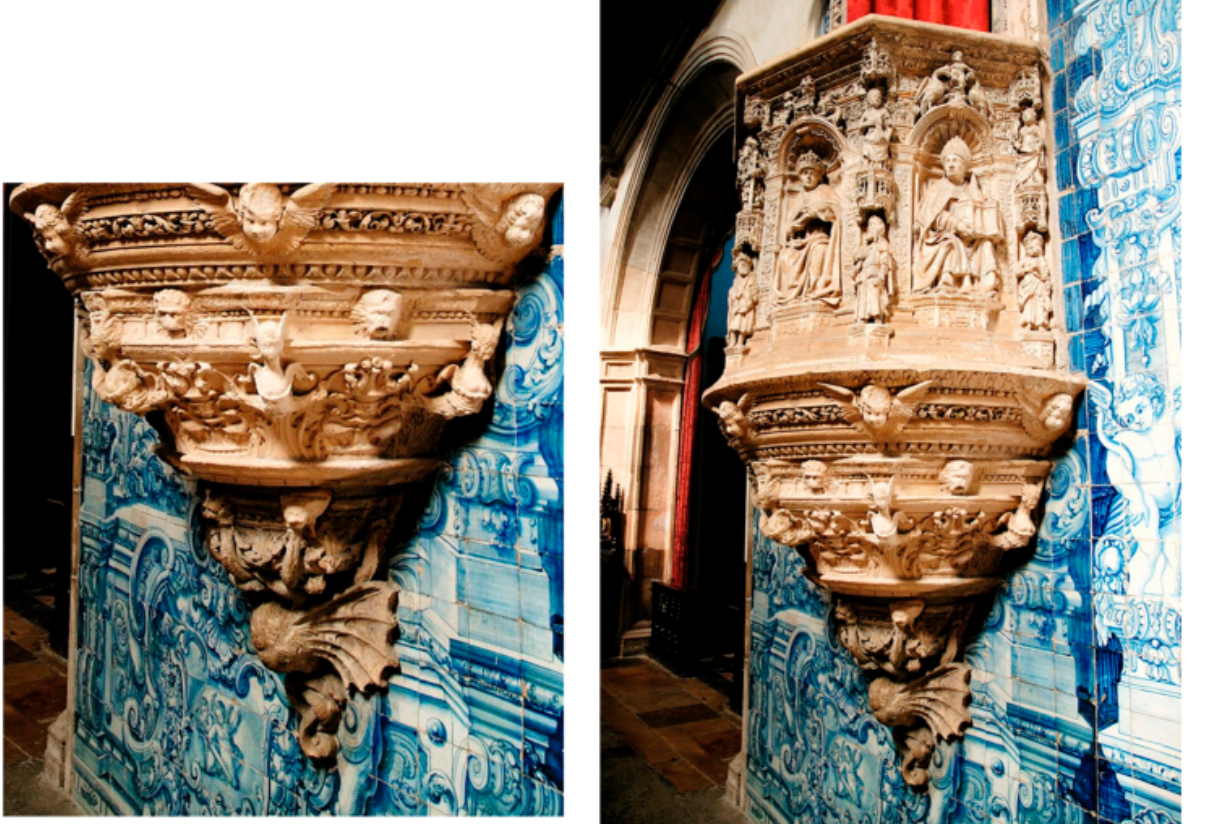
Figure 12. Renaissance stone pulpit, Church of Santa Cruz, Coimbra, Portugal. Probably carved by Nicolas Chantereuse (b. Normandy),